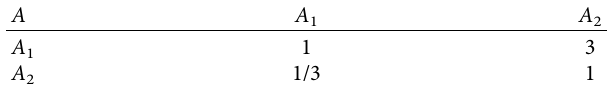
Table 20: Hierarchical total sorting